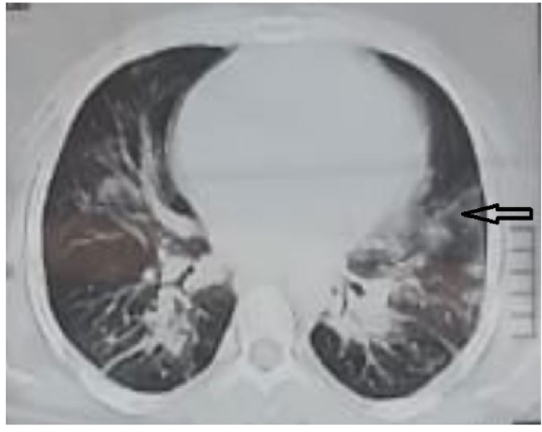
Fig. 2 CT of a female patient presented with 25% burn CT chest show areas of the alveolar filling (black arrow)